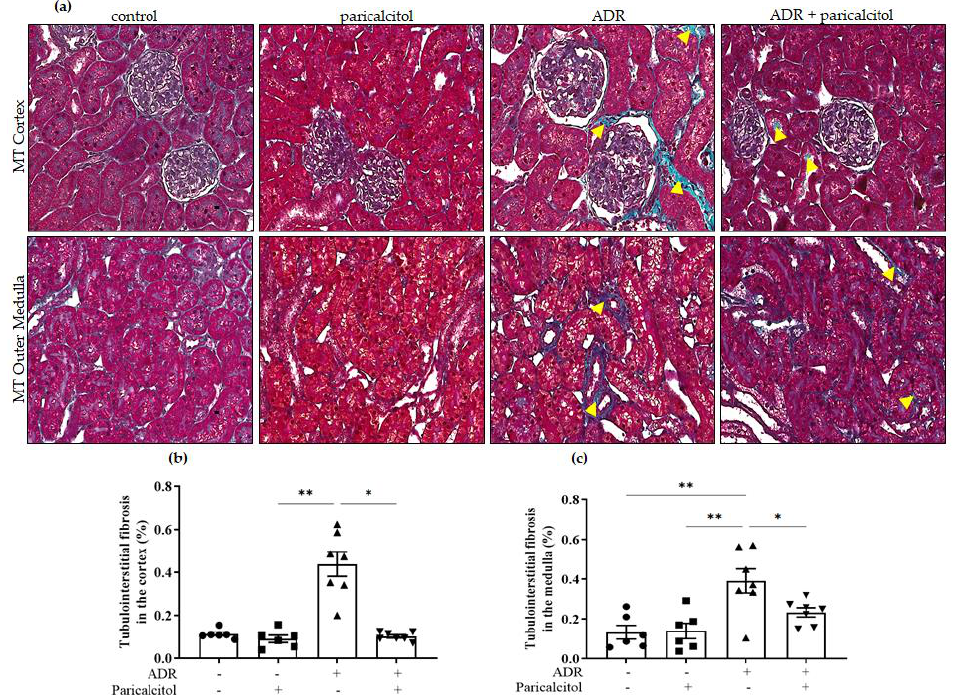
Figure 3. Representative Masson’s trichrome (MT) staining of kidney sections. ( a ). The top row represents the MT in the renal cortex, and the lower row represents the MT in the medullary compartment. The yellow arrowheads indicate the positive MT expression in tubulointerstitial compartments in the renal tissue. ( b ). Tubulointerstitial fibrosis in the renal cortex. ( c ). Tubulointerstitial fibrosis in the medullary compartment. Data from the control (dots), paricalcitol (squares), ADR (up triangles), and ADR + paricalcitol (down triangles) groups at 27 days of paricalcitol treatment. Scale bar = 20 µ m, n = 6 – 7 for each group. Data are expressed as the mean ±SEM. * p < 0.05; ** p < 0.01. The expression of JG12, an EC marker, was reduced in the renal glomerulus and the tubulointerstitial compartments of the renal cortex and outer medulla in the ADR group compared to the control groups. In the animals treated with paricalcitol, there was atten- uation in these alterations compared to the ADR group (Figure 4a – d).